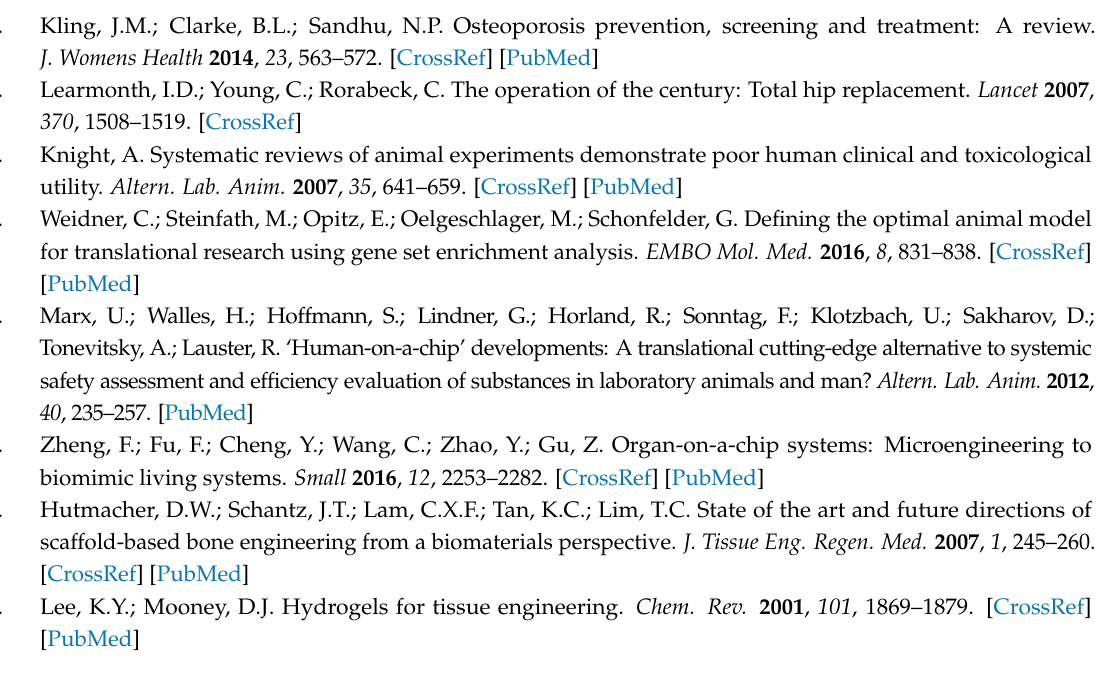
Table S1: Overview on scaffold based bone models published between 2007 and 2017, Table S2: Summary of bioreactors suitable for bone models, Table S3: Summary of microfluidic bone models. References [221–256] are cited in the supplementary